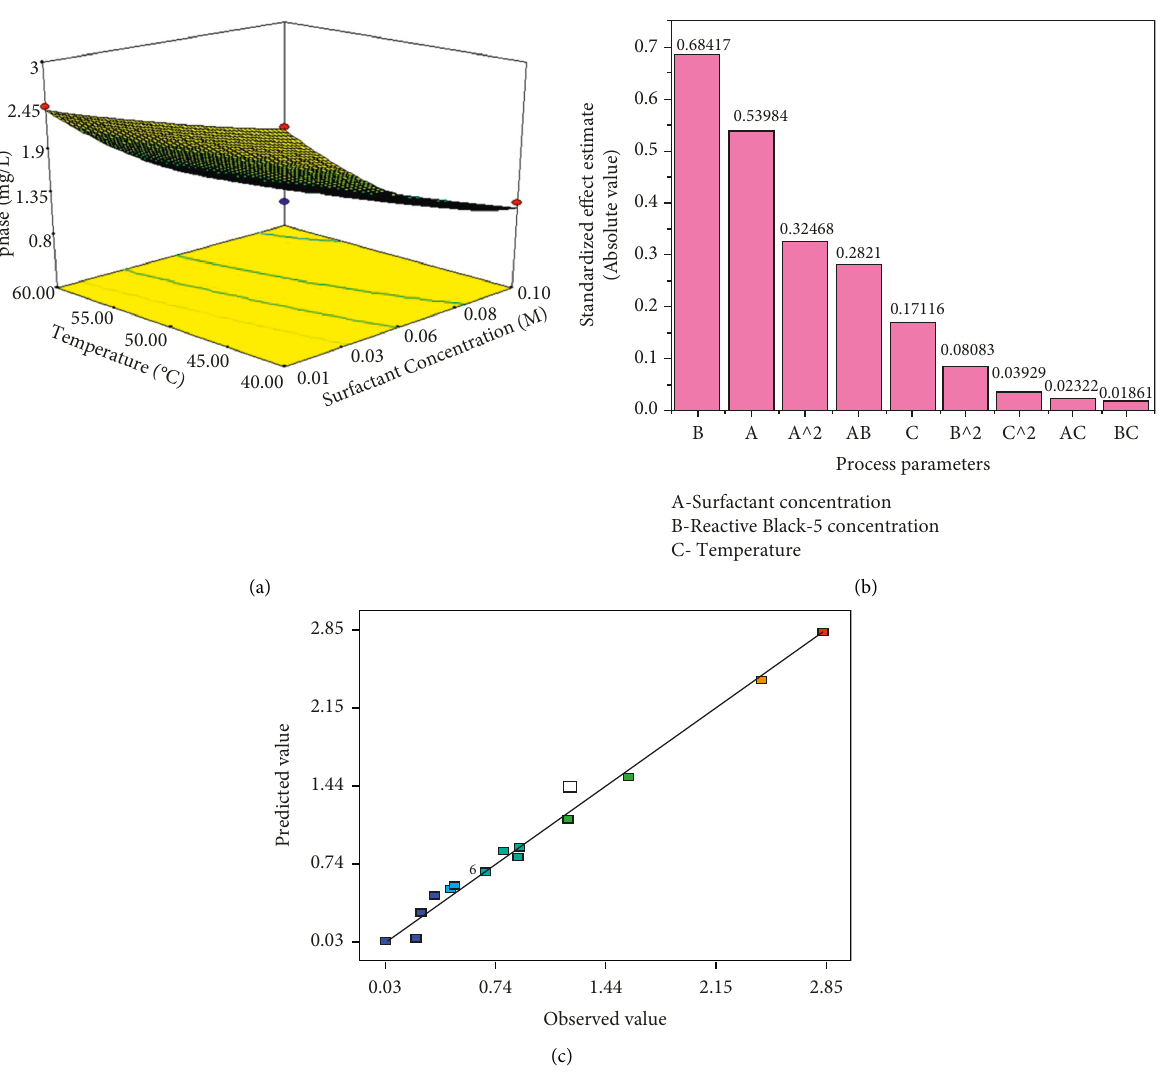
Figure 7: (a) Response surfaces for dye concentration in the surfactant-rich phase. (b) Pareto chart for dye concentration in the surfactant- rich phase. (c) Relationship between predicted values of dye concentration in the surfactant-rich phase and the observed value.